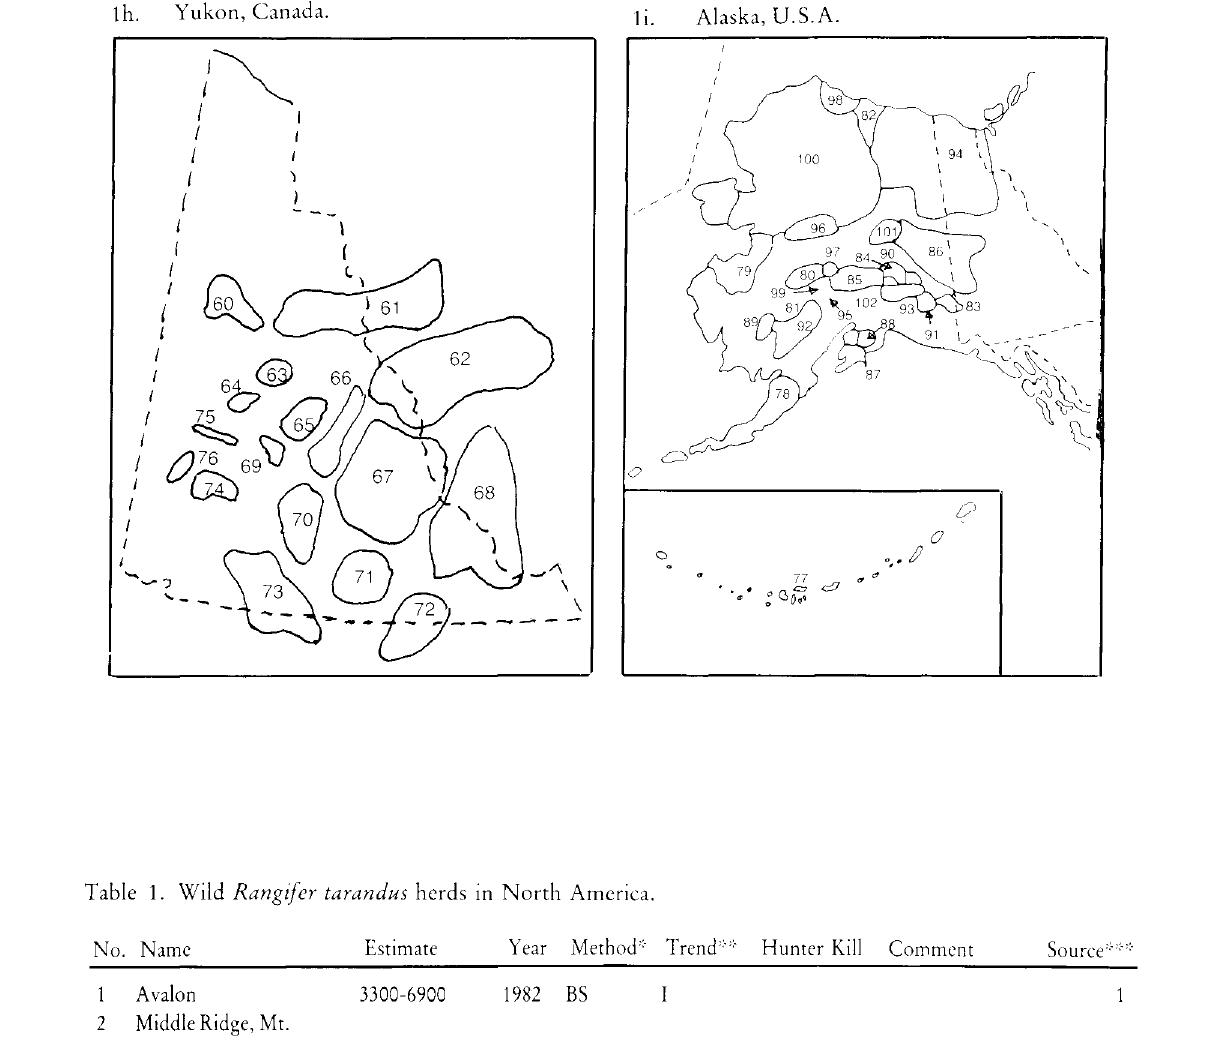
Table 1. Wild Rangifer tarandus herds in North